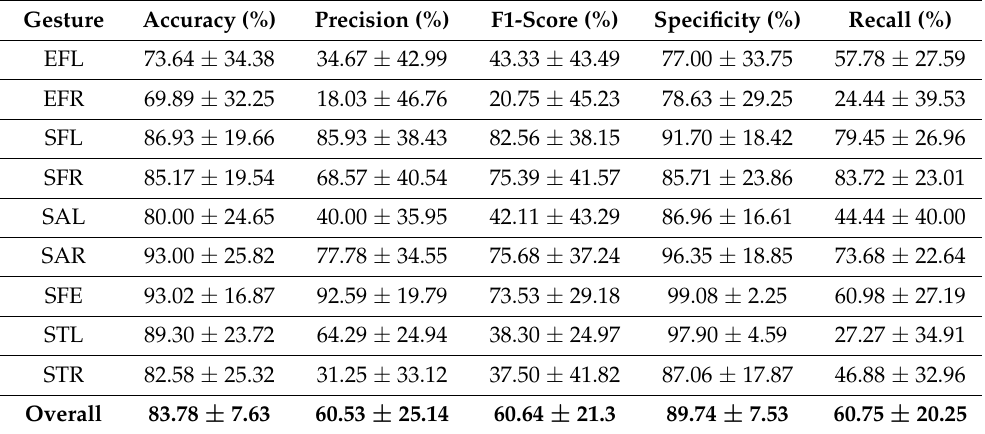
Table 3. LOSO results for all